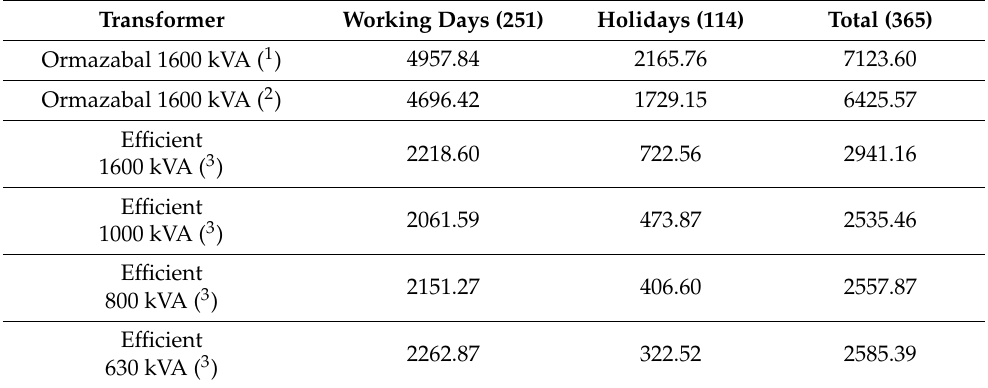
Table 13. Annual carbon dioxide emissions, in kg/year: ( 1 ) current operation; ( 2 ) optimizing operation of capacitors; and ( 3 ) using efficient transformers and optimizing the operation of capacitor